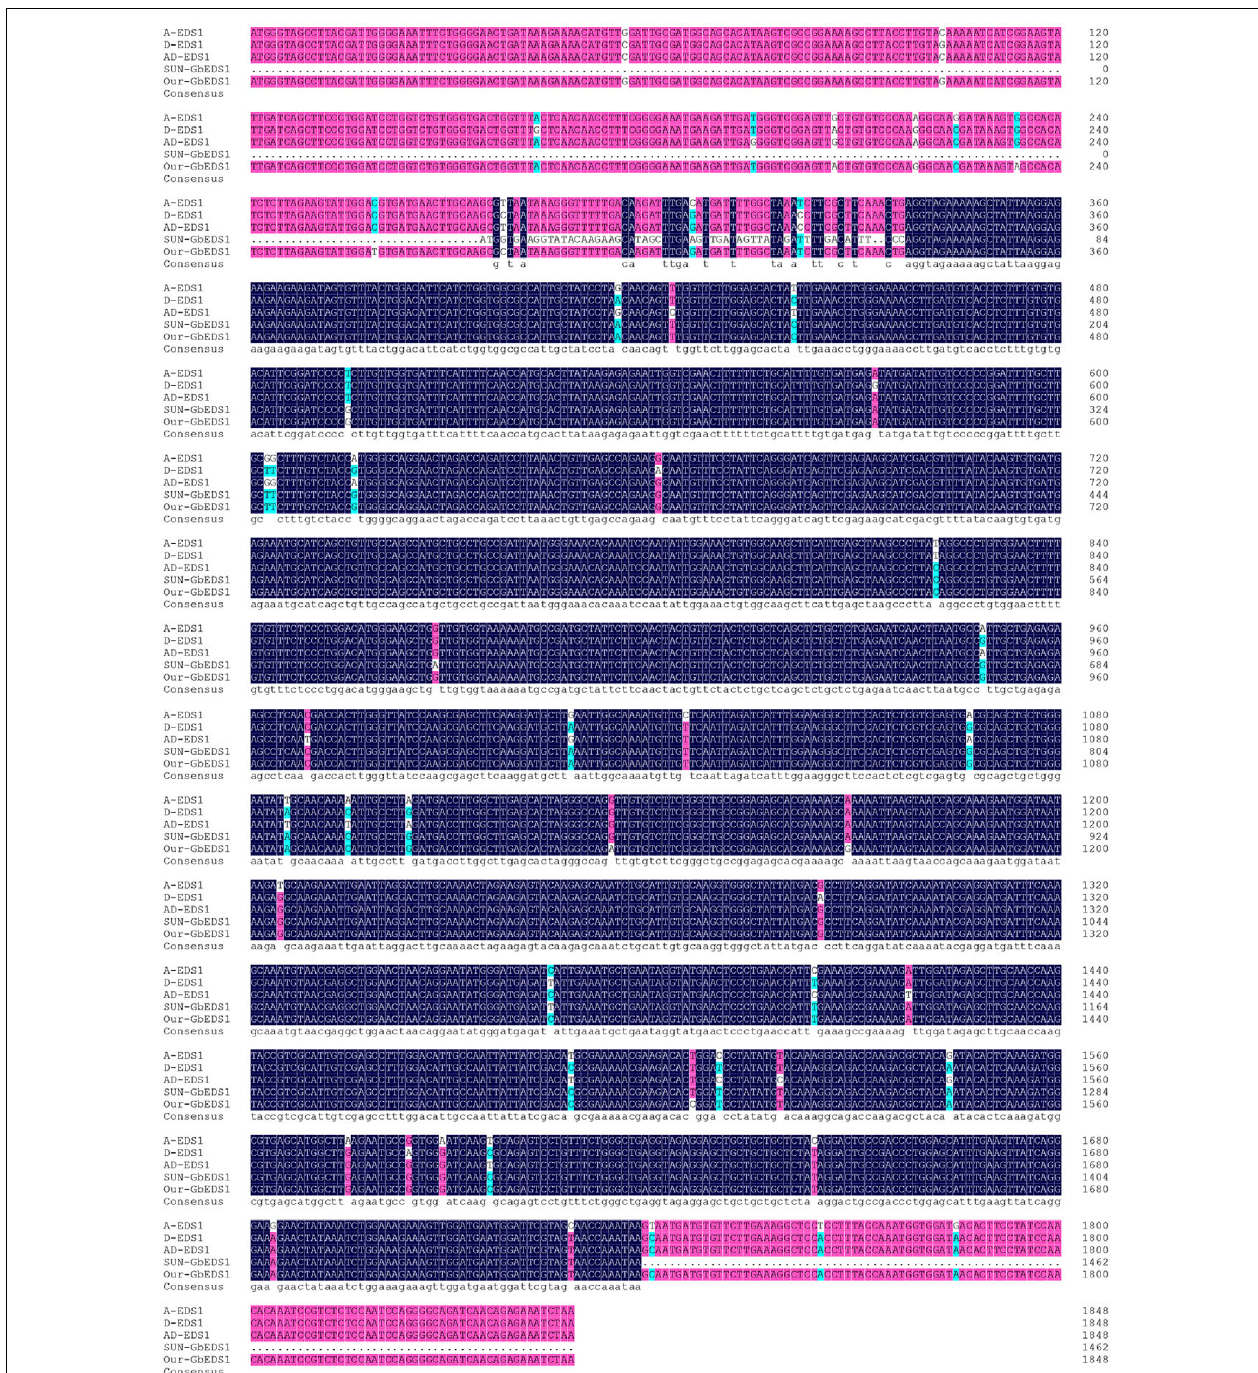
FIGURE 2 | Alignment of the sequences of GbEDS1 with its homologous genes in cotton. Comparison of the sequence of EDS1 from G. barbadense , G. hirsutum , G. arboreum , and G. raimondii .